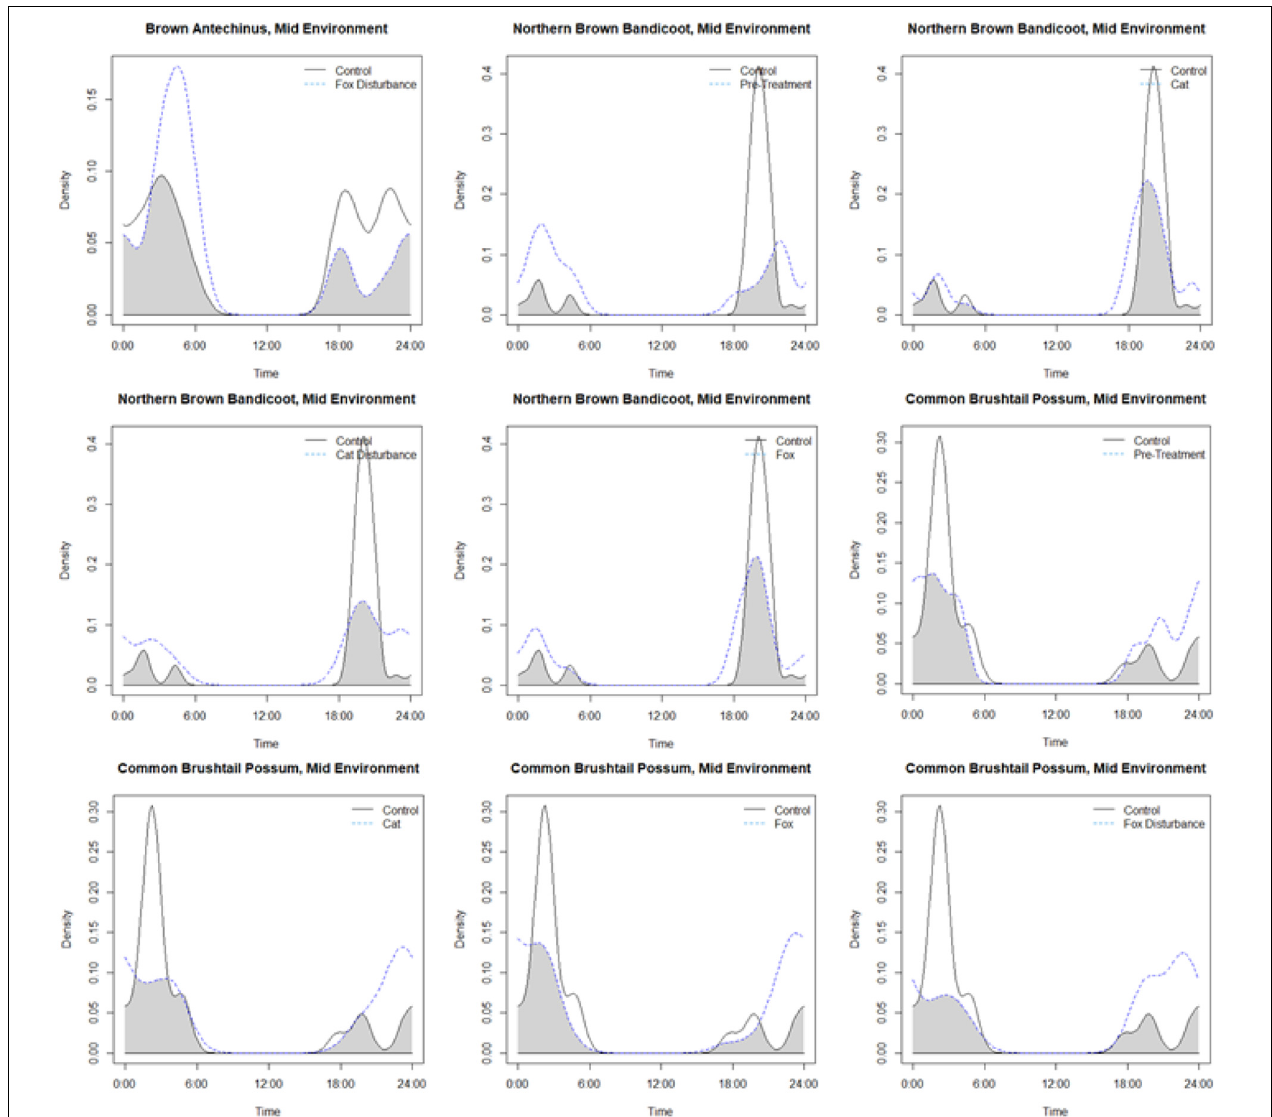
FIGURE 4 | Density pair plots for the lowest observed overlap coefficients for hours active by small mammals at giving-up density stations (baited with live mealworms), for species across the treatments compared to the procedural control (pre-treatment: three nights of trials under natural conditions before the treatment trials, disturbance: human disturbance cues of continual sound and light, cat: domestic cat cues of cat integumentary scent captured on towels placed in their bedding, cat with human disturbance: the combination of these stressors, fox: red fox cues of fox integumentary scent captured on towels placed in their bedding, fox with human disturbance: the combination of these stressors). All of the lowest overlap calculations were observed at the mid environment on an urban disturbance gradient (of close, mid, and